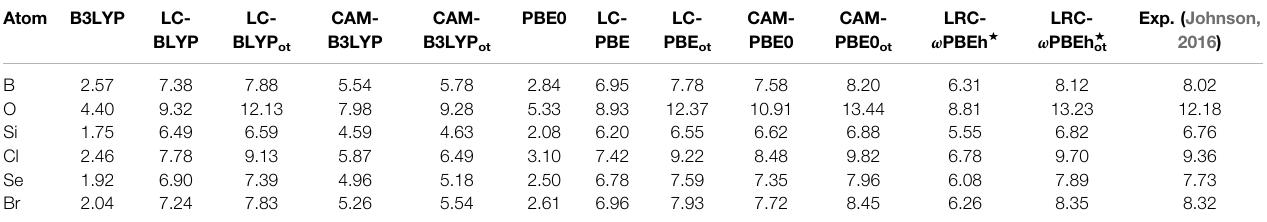
TABLE 10 | Ionization energies, − ϵ HOMO for selected atoms and molecules in eV, adopted from Ghosal and Roy (2022a). System B3LYP LC- Atom Be